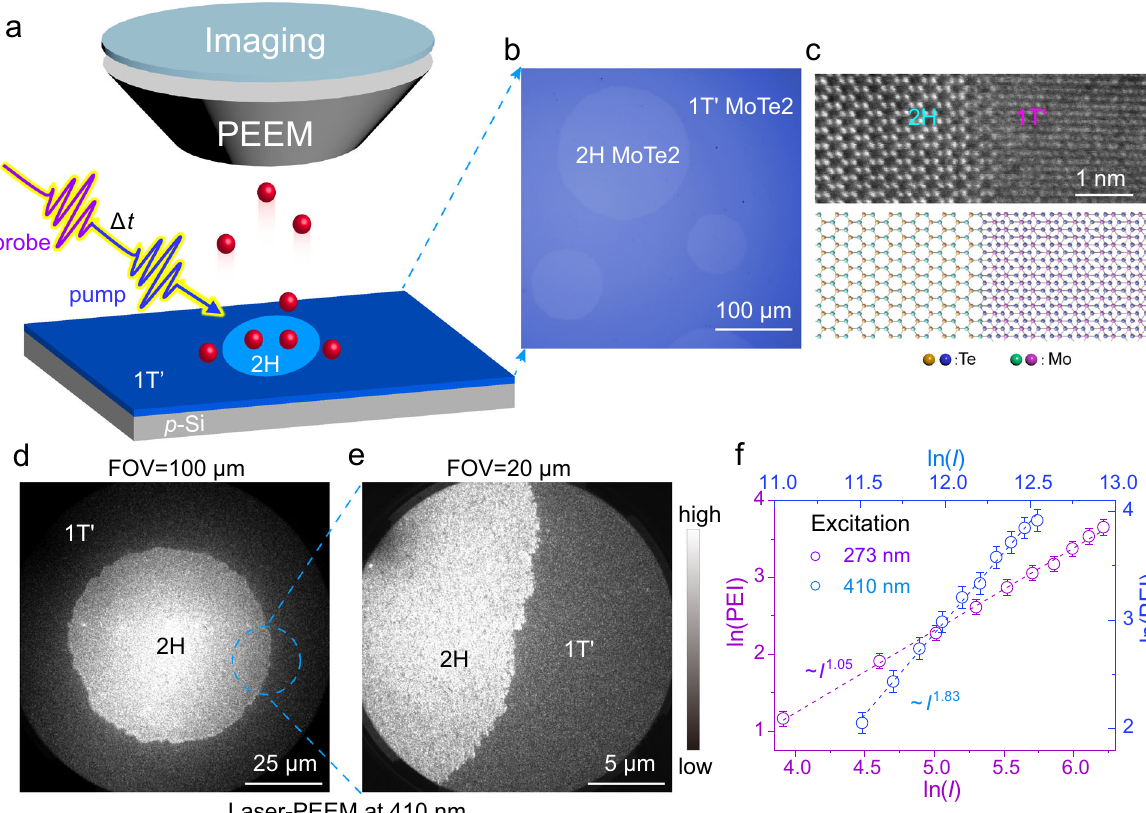
Fig. 1 Schematic of TR-PEEM setup and steady-state PEEM images of the 1 T ′ /2H-MoTe 2 heterojunction. a Schematic of the TR-PEEM setup, where the 410 nm and 273 nm pulsed lasers were used as the pump and probe beams, respectively. “ Δ t ” indicates the time delay of pump – probe pulsed lasers. b Optical image of the MoTe 2 grown on a p -type silicon substrate ( p -Si), scale bar is 100 μ m. c The HAADF-STEM image (scale bar is 1 nm), as well as the schematic lattice of the 1 T ′ /2H-MoTe 2 interface. d Steady-state PEEM image of the heterojunction with a FOV of ~100 μ m illuminated by the 410 nm pulsed laser (laser-PEEM at 410 nm). Scale bar is 25 μ m. e Steady-state PEEM image of the blue circled region in d with a FOV of ~20 μ m illuminated by the 410 nm pulsed laser. Scale bar is 5 μ m. f PEI versus the laser fl uence on a logarithmic scale. I indicates the laser fl uence. Error bars are